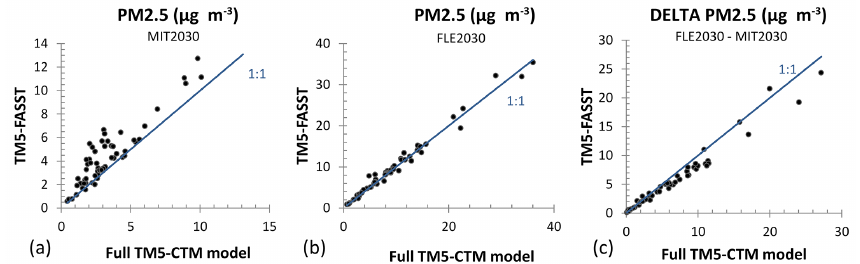
Figure 8. Population-weighted mean PM 2 . 5 concentration computed with TM5-FASST versus TM5 CTM for low-emission scenario MIT2030 (a) , high-emission scenario FLE2030 (b) , and the change between the two. Each point represents the population-weighted mean over a TM5-FASST receptor region. The blue line is the 1 : 1